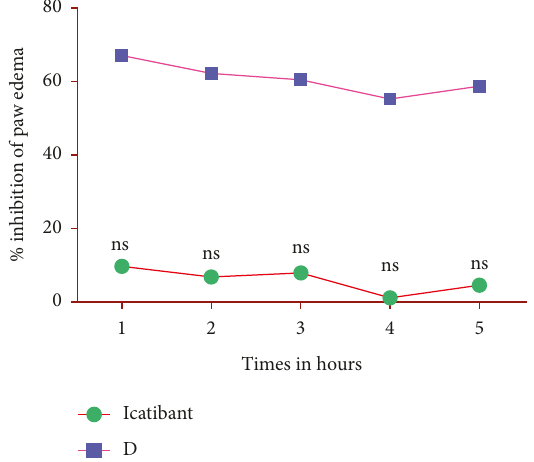
Figure 3: Percent inhibition produced by compound D (100mg/ kg) and chlorpheniramine maleate (25mg/kg) in the histamine- induced paw edema model in mice. Each percent point represents the mean SEM for a group of 8 mice. Data were analyzed by Student’s t -test. Asterisks show significant values. ±